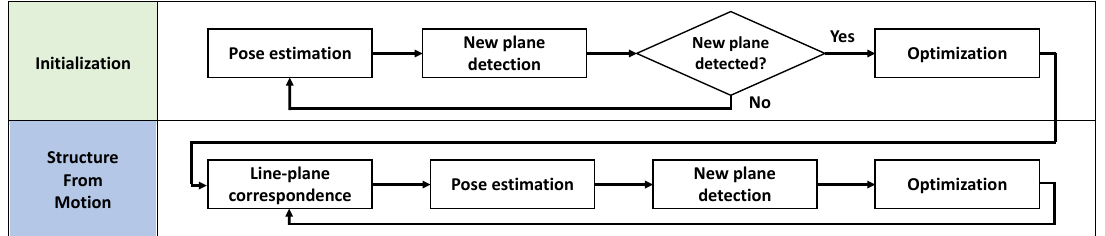
Figure 1. Flow chart of the proposed